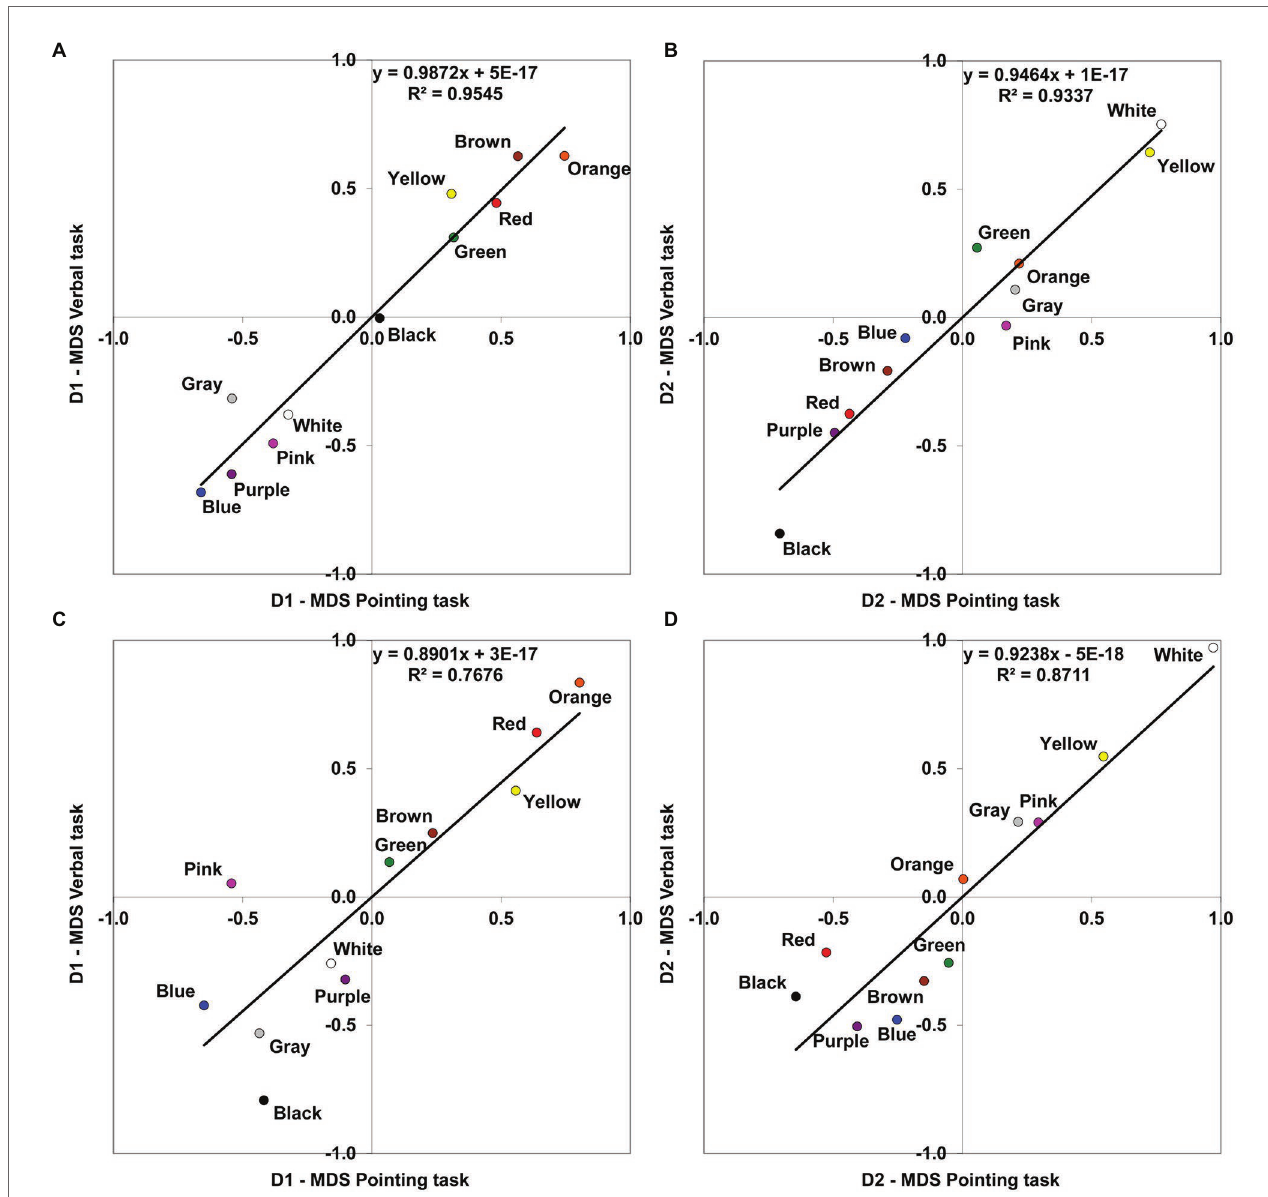
FIGURE 2 | Comparison of MDS solutions derived from the pointing and the verbal tasks. Linear relationships are shown between the corresponding dimensions (D1, chromatic; D2, achromatic) obtained in the MDS analyses for the two different tasks. (A) Protanopes, D1. (B) Protanopes, D2. (C) Deuteranopes, D1. (D) Deuteranopes, D2. The continuous line represents the least squares linear regression fit (the corresponding equations and R 2 values are shown in each